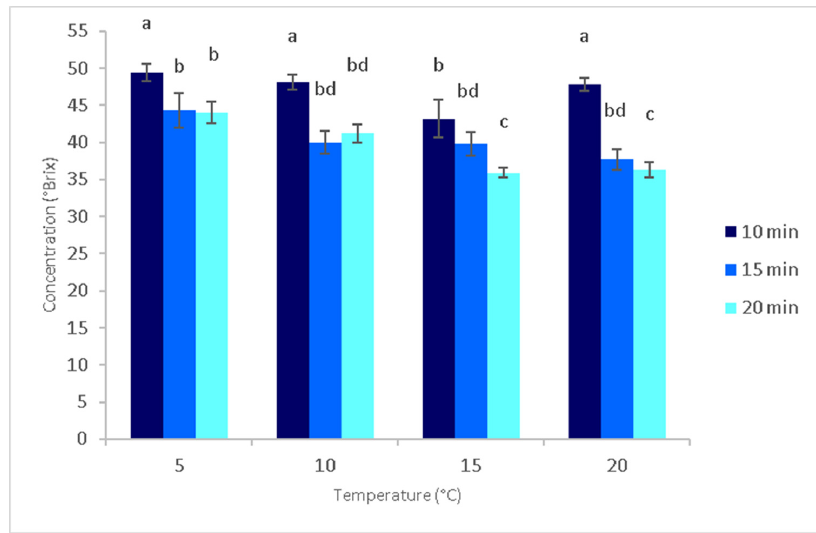
Figure 2. Results of concentration (°Brix) at different times and temperatures; a,b,c indicates there are significant differences at p ≤ 0.05, and b,d indicates there are no significant differences at p ≤ 0.05, both according to a least significant difference (LSD)